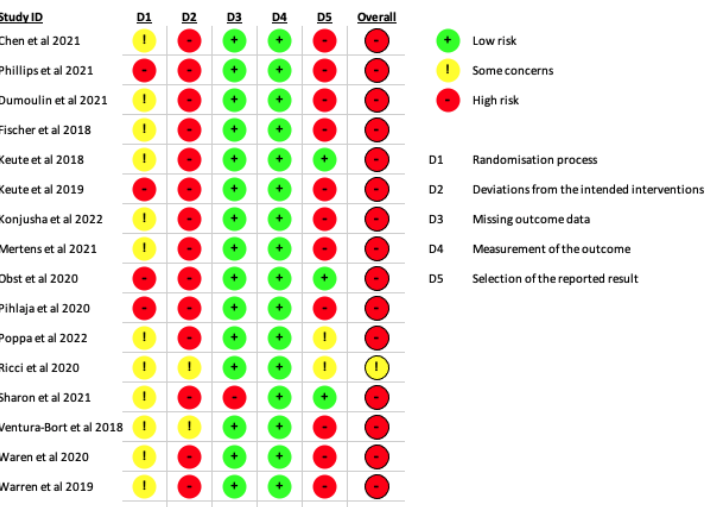
Figure 2. Risk of bias of the included studies.